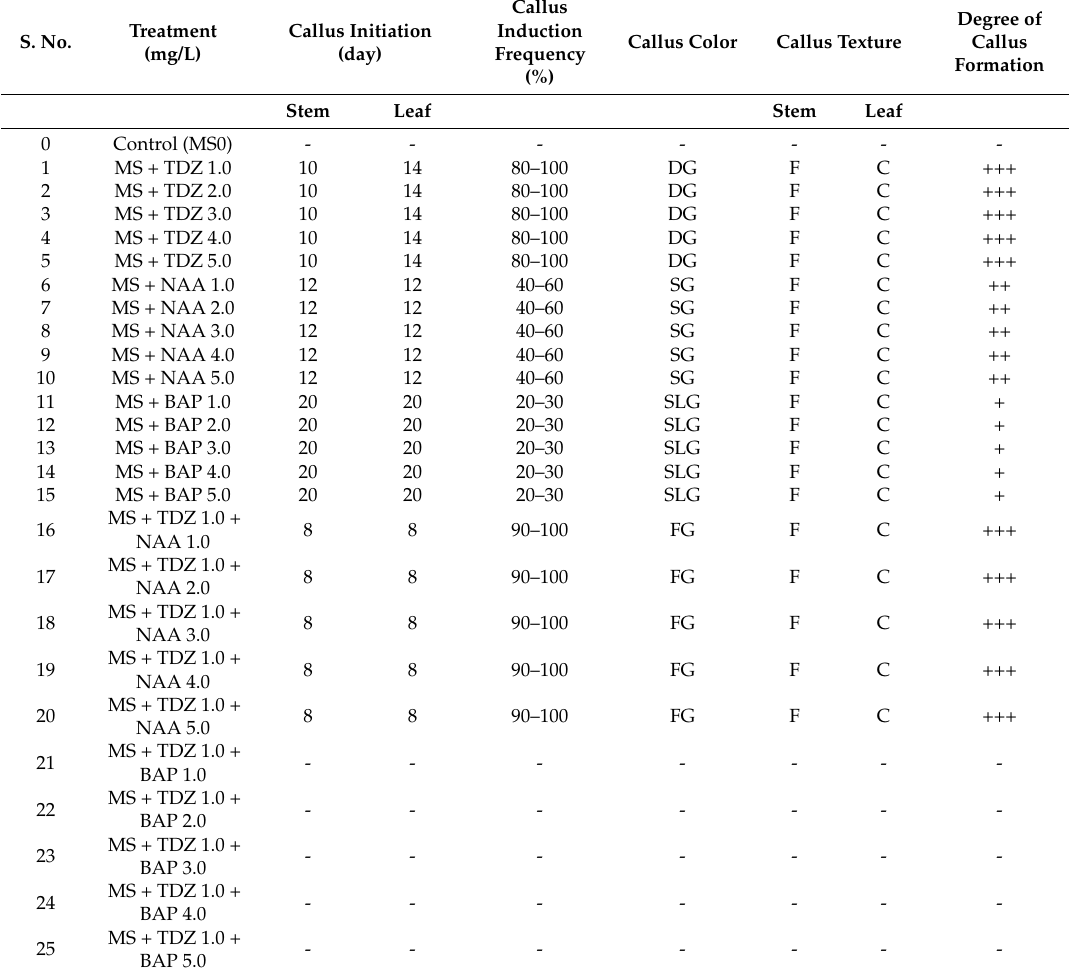
Table 1. Callogenesis, initiation (day) and morphology of stem and leaf callus under different PGRs after 5 weeks of